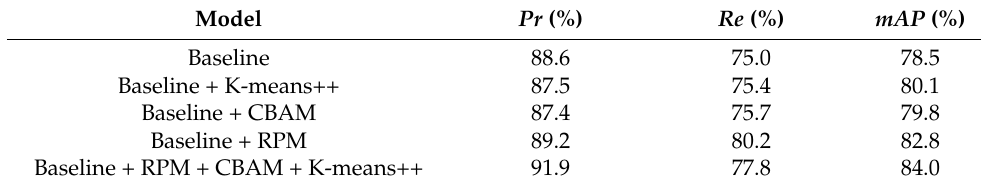
Table 3. Ablation experiment of YOLO